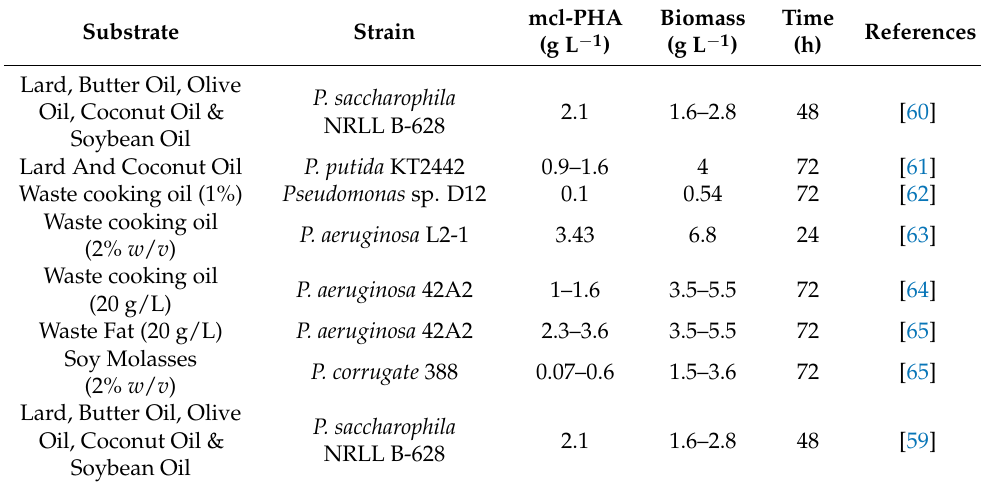
Table 2. Bacterial strains growing on different plant oils and waste substrates to produce PHA. Substrate